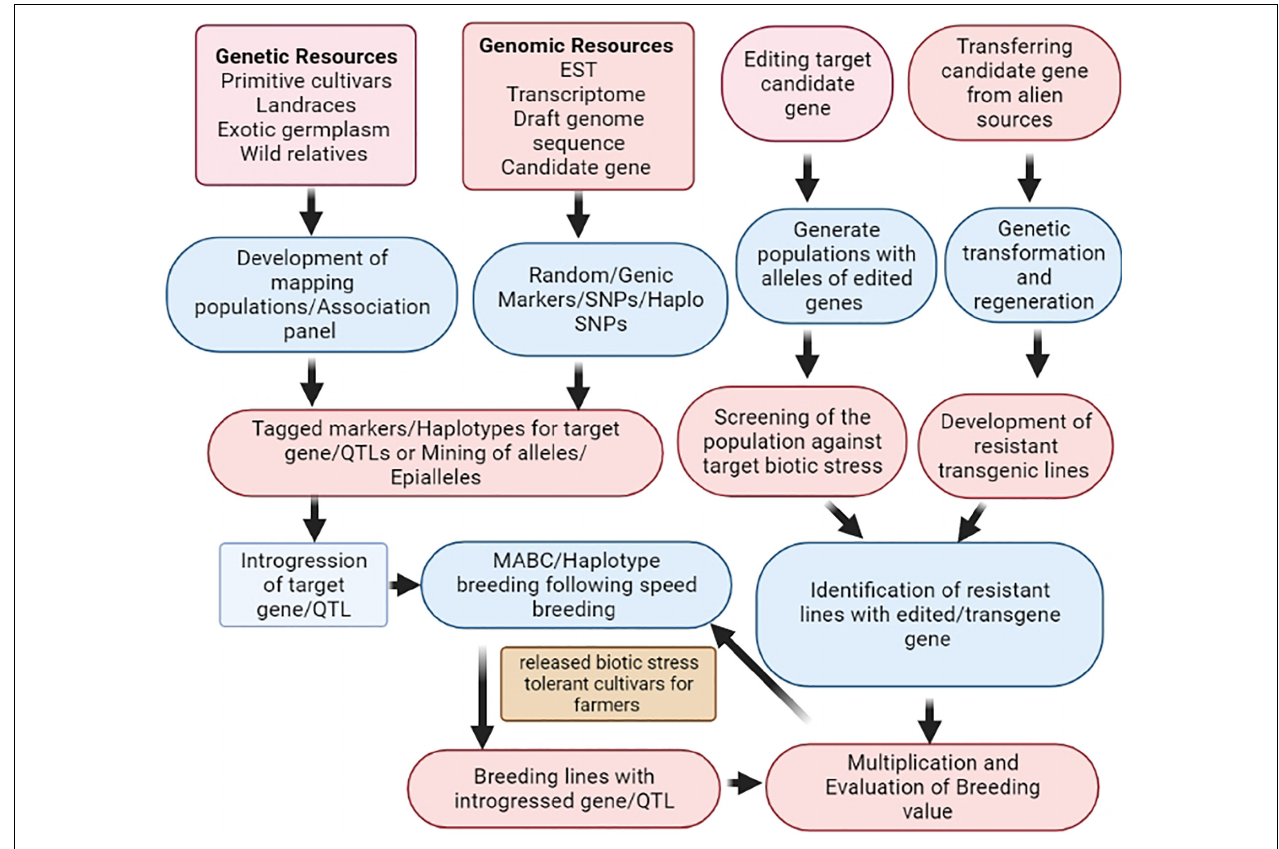
FIGURE 2 | Genomic-assisted breeding strategies for biotic stress